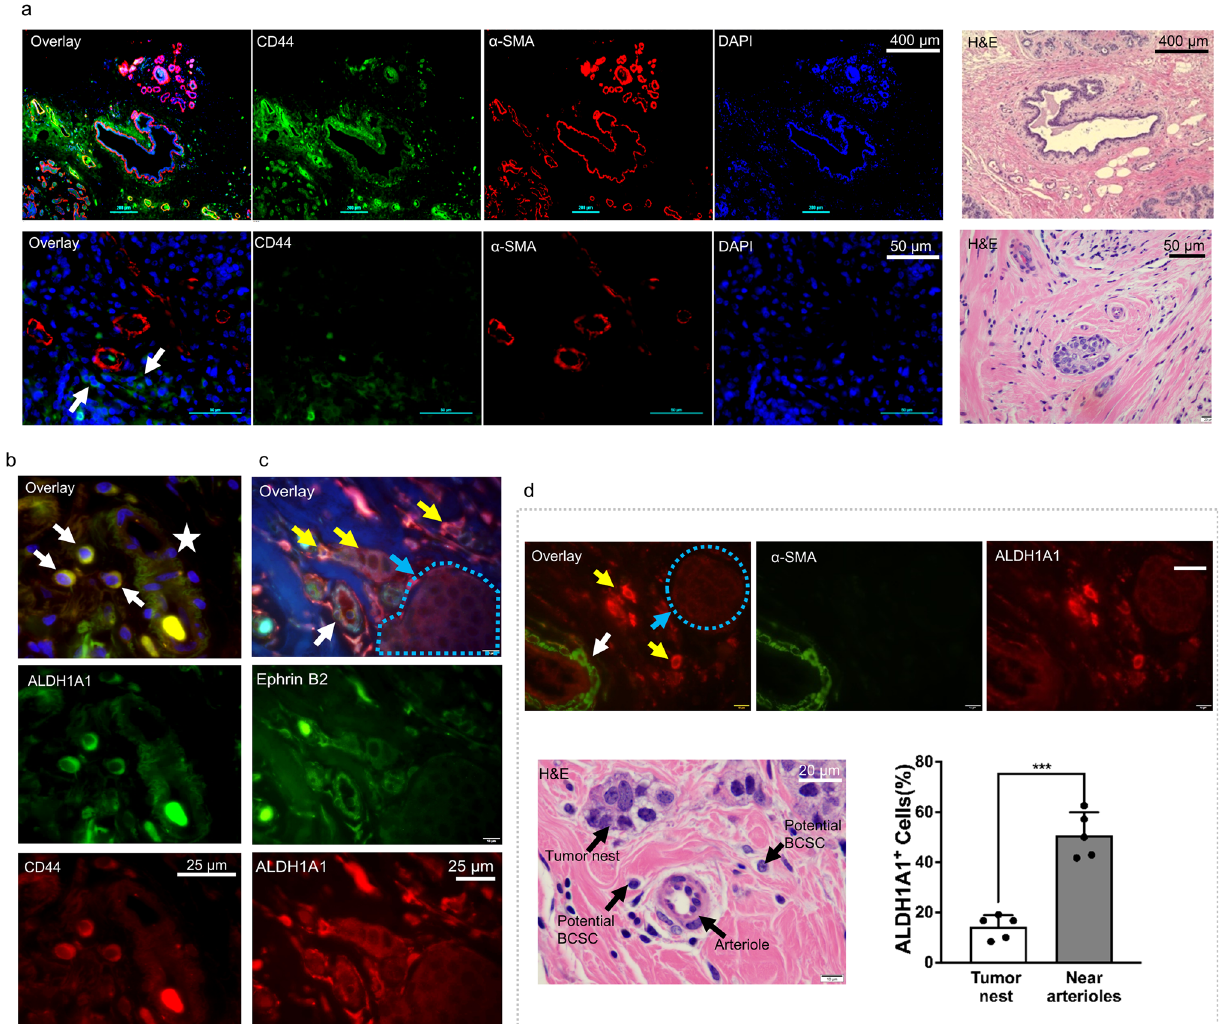
Fig. 1 Breast cancer stem-like cells are highly enriched within the arteriolar niche. a CD44 + cancer cells within a vascular niche (white arrows), as shown by staining with α -SMA (red) in human ER + breast cancer. DAPI (blue) is used for nuclei staining. Normal tissue control (upper panel) refers to the tissues adjacent to breast cancer. Tissue structures are shown by H&E staining. Scale bar = 400 µ m (upper panel) or 50 µ m (lower panel). b BCSCs in a human BC specimen within TME. Human ER + BC specimen was co-stained with anti-CD44 and anti-ALDH1A1 antibodies, followed with appropriate second antibodies, and mounted with DAPI. Images were acquired using an Eclipse T i 2 ® Nikon microscope and overlaid using NIS Elements software. BCSCs are indicated by white arrows and the blood vessel-like structure is shown by a white star. No CD24 was detected. Shown are representative images. Bar = 25 µ m. c Ephrin B2 and ALDH1A1 co-staining in human ER + BC specimens. Ephrin B2 was stained green and ALDH1A1 red. White arrows show ephrin B2 positive arteriole, yellow arrows indicate ALDH1A1 + cancer cells, and tumor nest is indicated by the blue dashed circle. Cells in the cancer nests as indicated did not show signi fi cant ALDH1A1 staining (blue arrow). Scale Bar = 10 µ m. d Quanti fi cation of ALDH1A1 + BC cells within the arteriolar niche. The arteriole is indicated by the white arrow, ALDH1A1 + BCSCs were shown by yellow arrows, and tumor nest was indicated by the blue dashed circle and BCs with low ALDH1A1 expression occurred within the tumor nest (blue arrow). H&E staining as a tissue structure control. Scale bar = 10 µ m. BC cells were randomly counted under an Olympus BX60 fl uorescence microscope linked with a CCD camera. The standard for examining cell locations was: (1) closed to the artery is de fi ned as ALDH1A1 + BC cells within 50 µ m from the SMA + small arteries, and (2) close to the cancer nest refers to ALDH1A1 + BC cells locating cancer cell nest more than 50 µ m from the SMA + small artery. Up to 30 cancer cells were randomly counted within 50 µ m × 50 µ m area with fi ve repetitions. The yellow arrows indicate ALDH1A1 + BCSCs. The dotted blue circle indicates a tumor nest containing BC cells to determine BCSCs that were localized more than 50 µ m from the α -SMA + arterioles. The bar graph shows relative numbers of ALDH1A1 + BCSCs that were related to either arteriolar niche or tumor nests in the BC tissues as detected by immuno fl uorescence microscopy. *** P < 0.001 compared with cells in the tumor